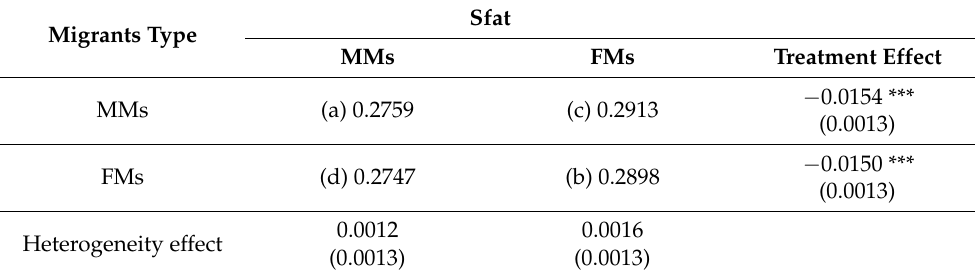
Table 7. Share of energy from fat, treatment, and heterogeneity effects of